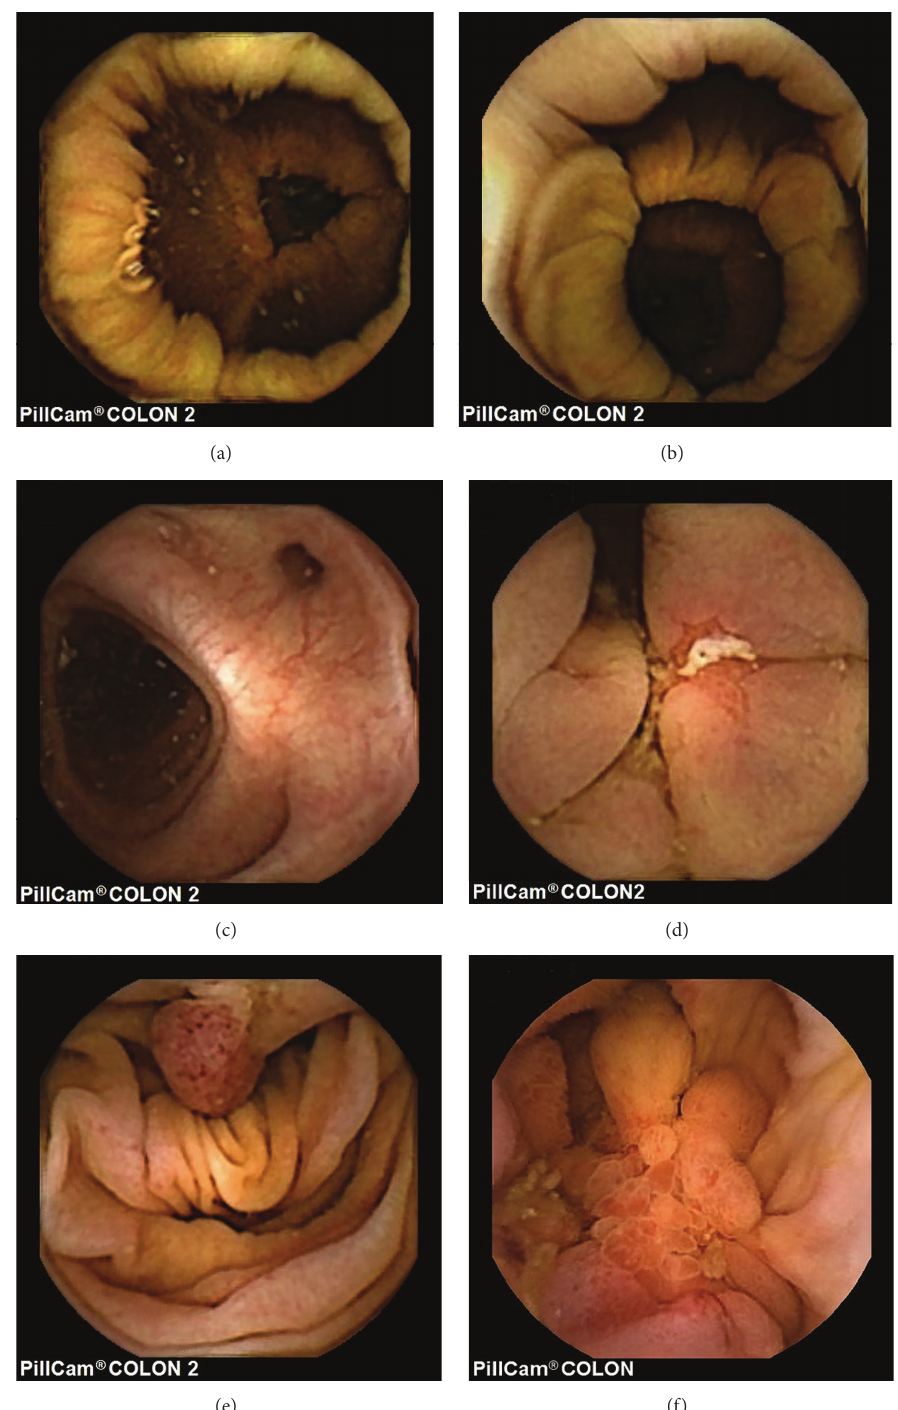
Figure 2: (a) Transverse colon. (b) Ascending colon. (c) Diverticulum. (d) Crohn’s disease. (e) Colon polyp. (f) Colon